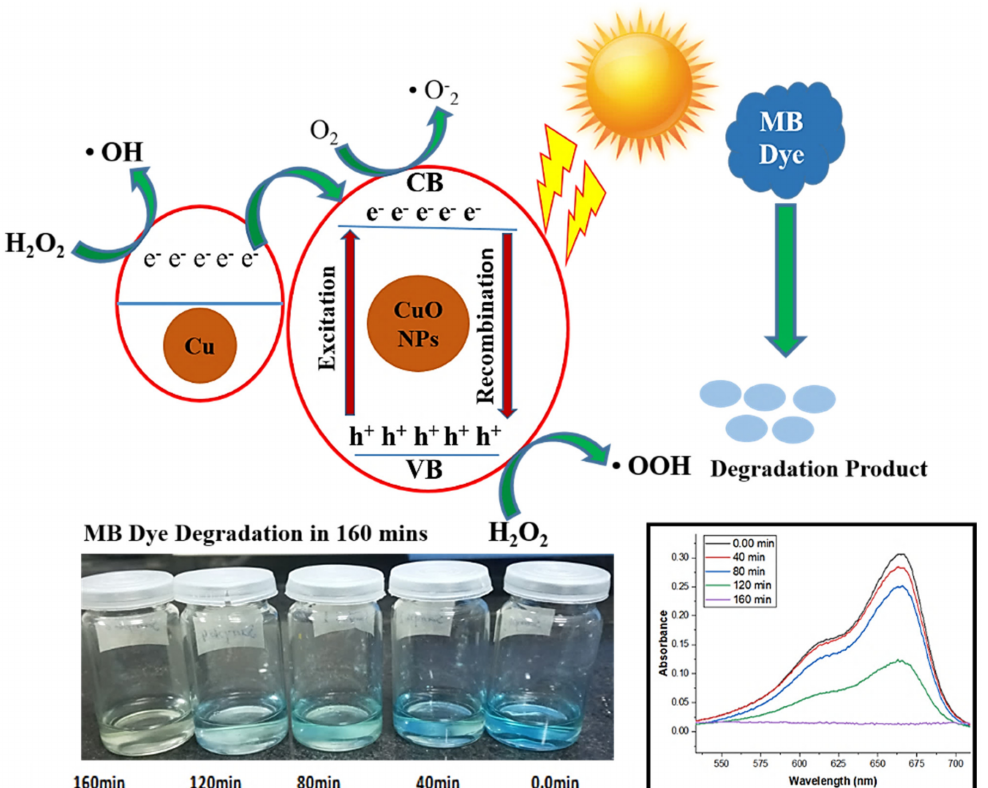
Figure 11. Process of MB dye degradation with exposure to